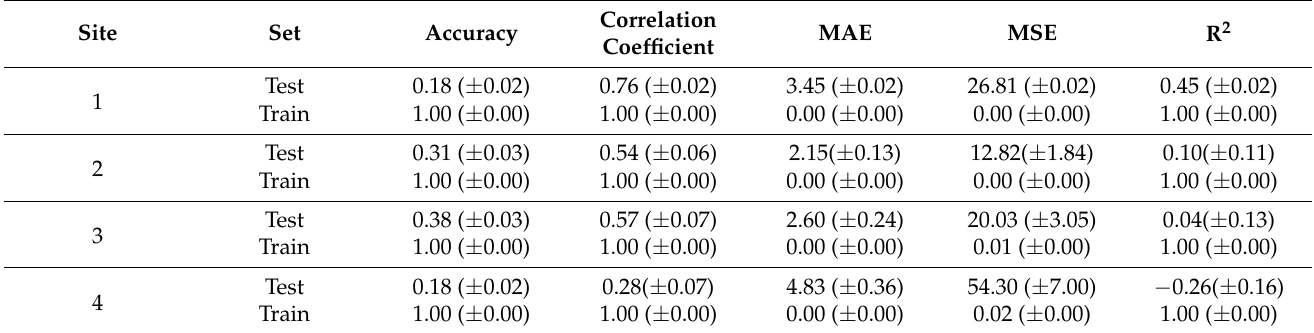
Figure 10. Accuracy as a function of the number of trees considered for site 1. Table 11 shows the values of the metrics for RFs. Table 11. Correlations obtained for RFs.